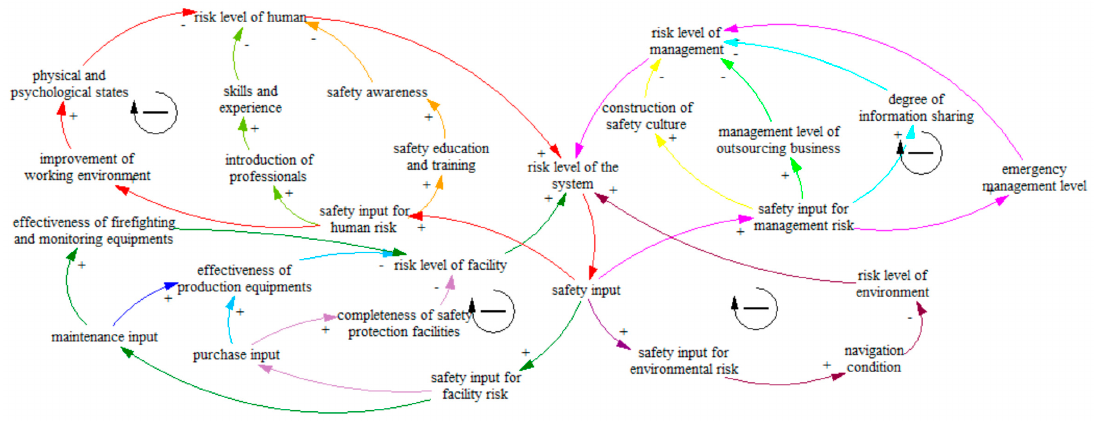
Figure 2. Causal loop diagram of the system.